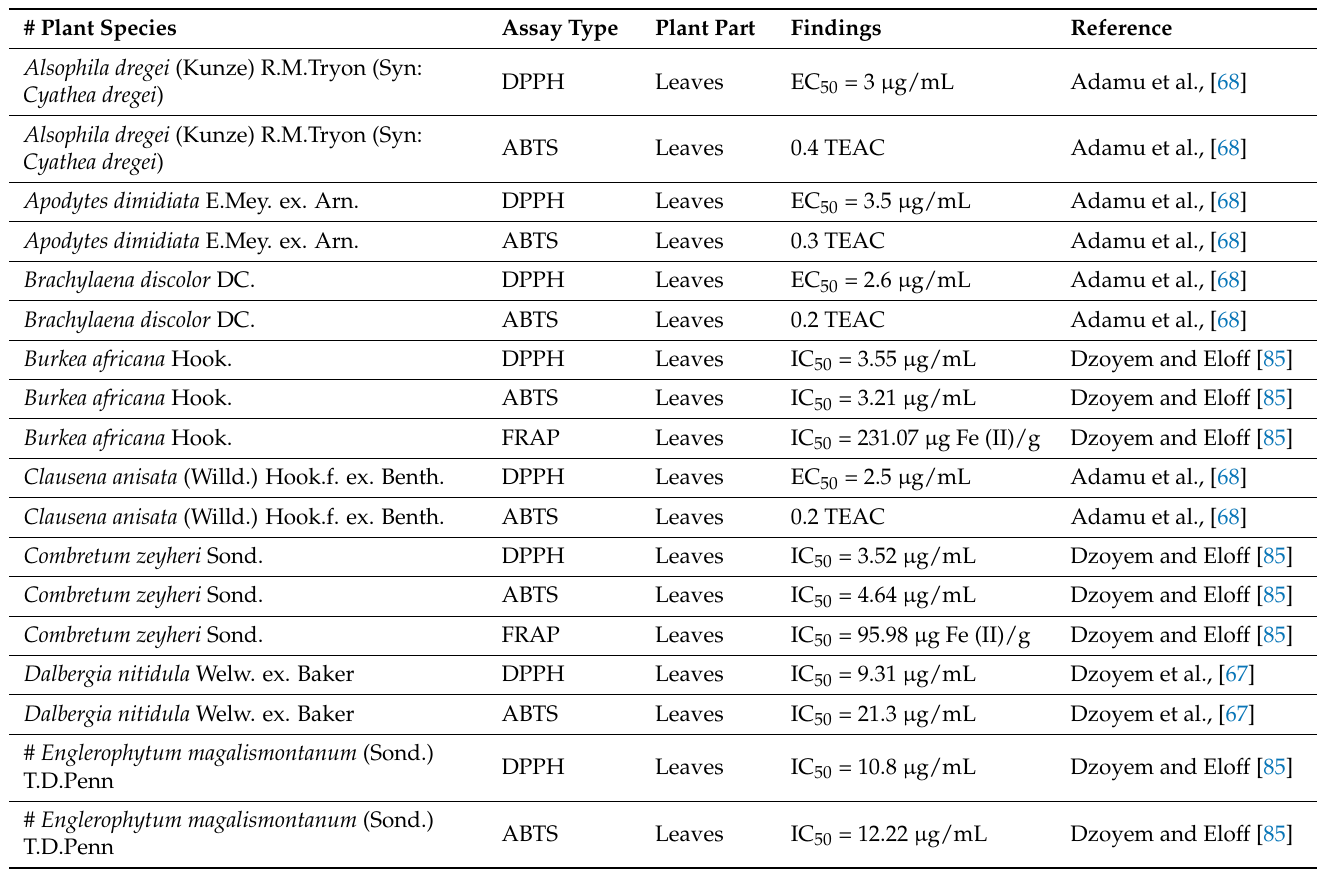
Table 5. Examples of in vitro antioxidant effect of woody plants used for ethnoveterinary medicine in South Africa. # Plant species: denotes woody plants with ethnoveterinary uses in Table 2. ABTS—2,2 (cid:48) -azinobis-(3-ethylbenzothiazoline-6- sulfonic acid), DPPH—1,1-diphenyl-2-picryl-hydrazyl, FRAP—ferric reducing antioxidant power, TEAC—trolox equivalent antioxidant